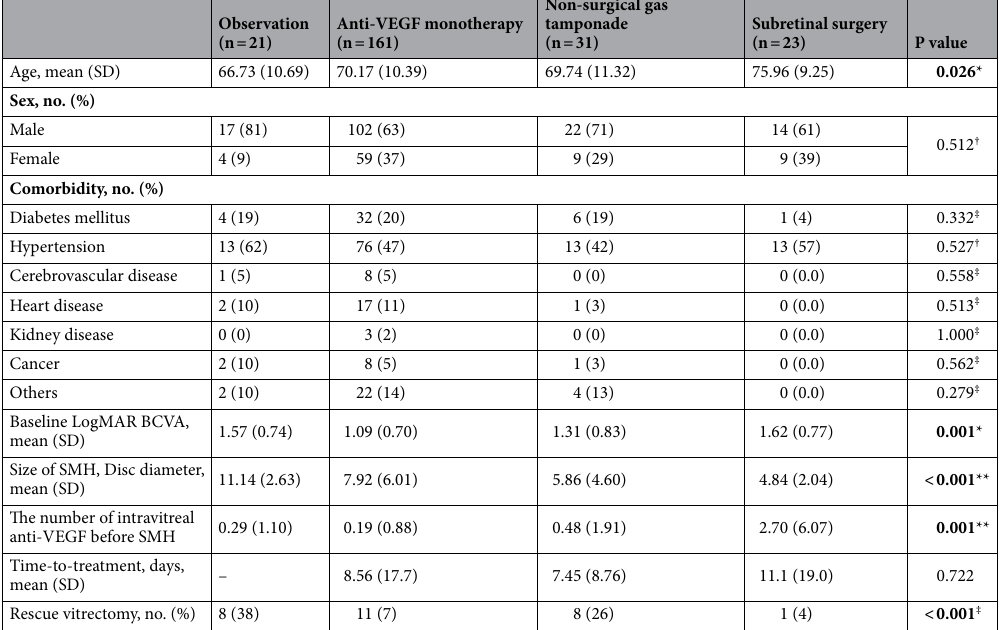
Table 1. Demographic and clinical characteristics for submacular hemorrhage patients with neovascular age- related macular degeneration. VEGF, vascular endothelial growth factor; t-PA, tissue plasminogen activator; SD, standard deviation; LogMAR, logarithm of the minimum angle of resolution; BCVA, best-corrected visual acuity; SMH, submacular hemorrage. *t-test. † chi-square test. ‡ Fisher’s exact test. **Kruskal–Wallis test. P values in bold are statistically